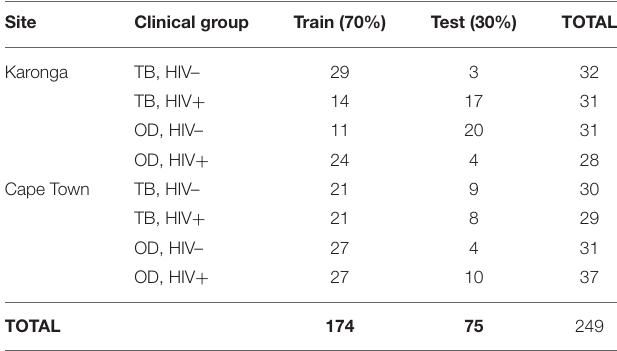
TABLE 5 | Numbers of patients in the ILULU-TB cohort allocated to train and test sets, for novel biosignature